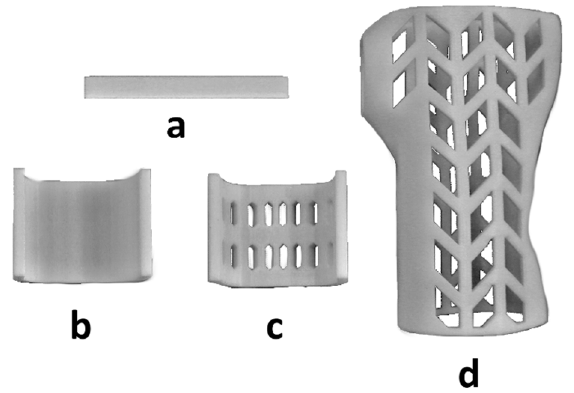
Figure 3. Manufactured samples, series: ( a ) P.1, ( b ) F.1, ( c ) O.1, ( d ) WHO.1.